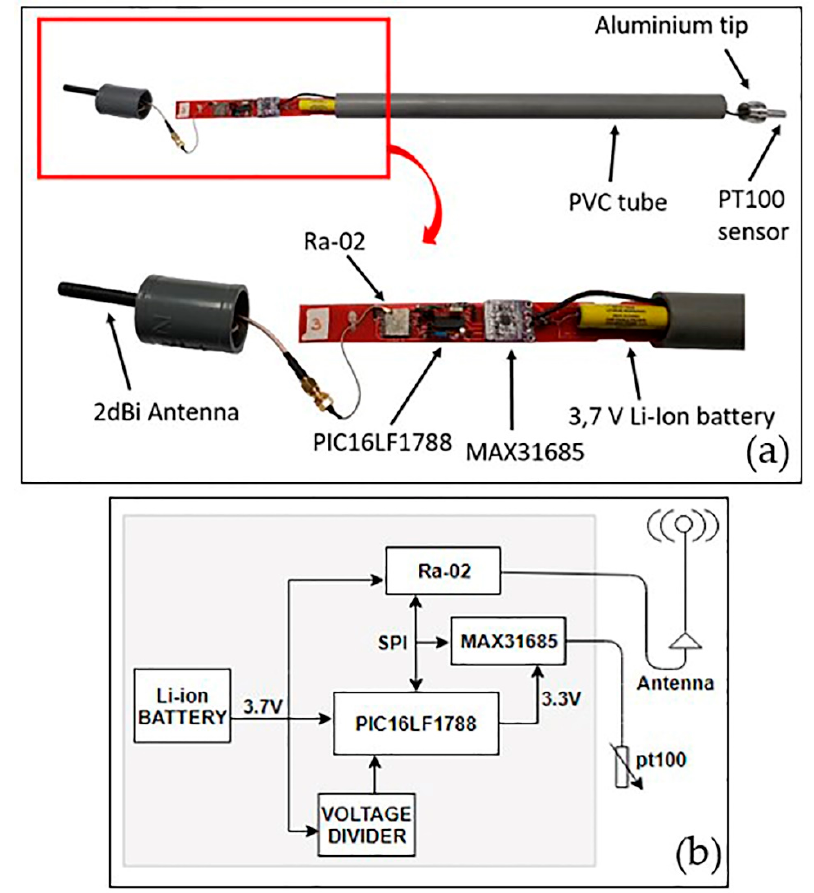
Figure 4. End device. Configuration ( a ) and general hardware scheme ( b ).